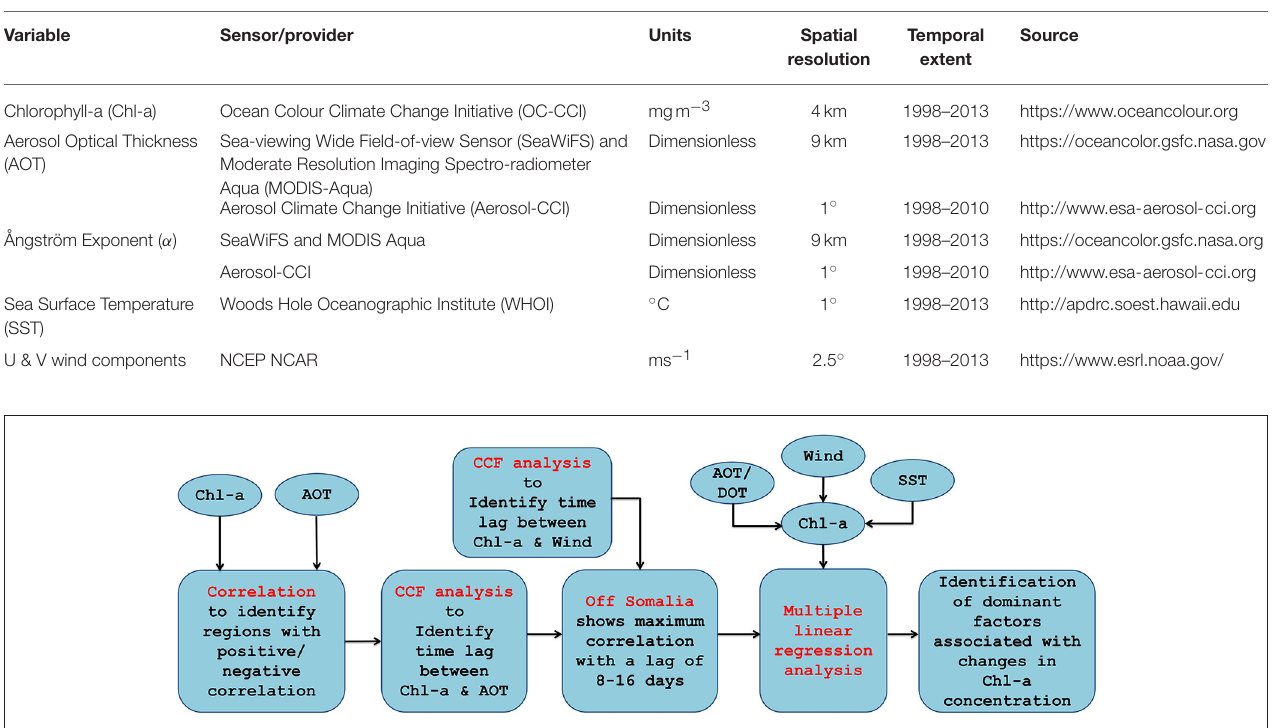
TABLE 1 | Summary of data sets analyzed in the study.